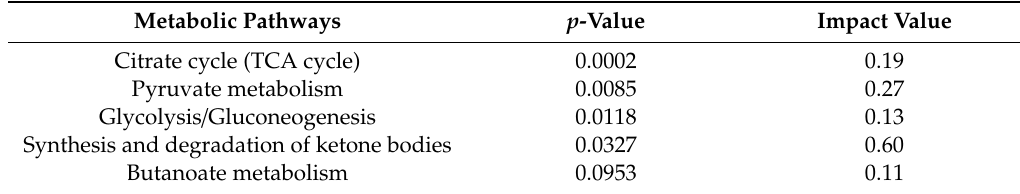
Table 6. Metabolic